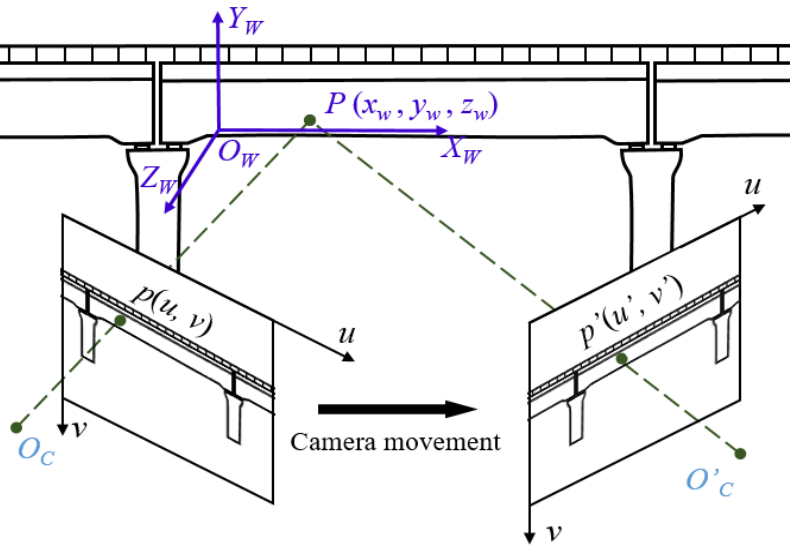
Figure 3. Geometrical relationship between image planes before and after the camera